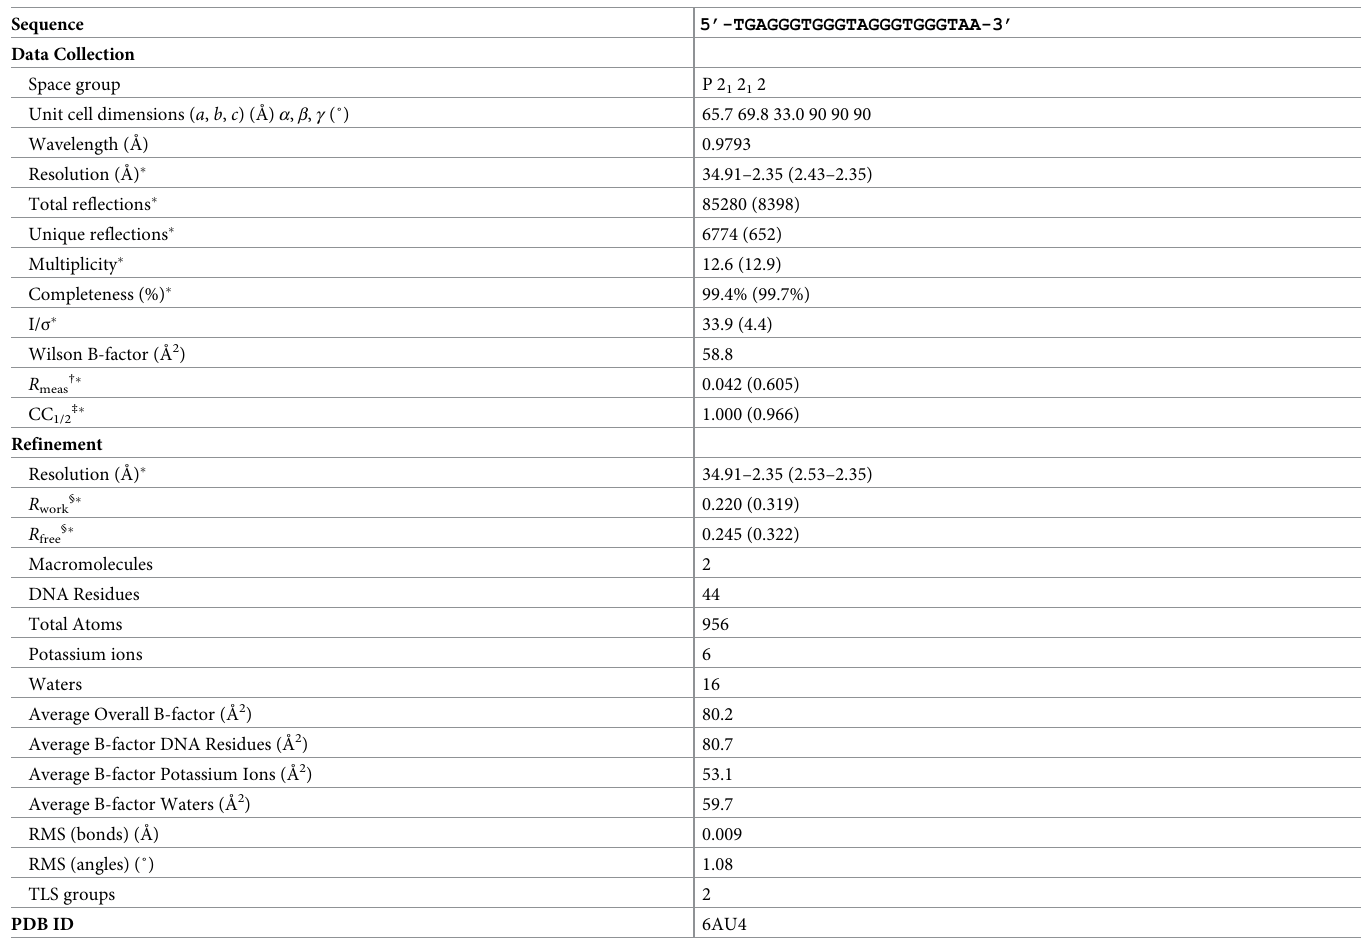
Table 1. Data collection and refinement